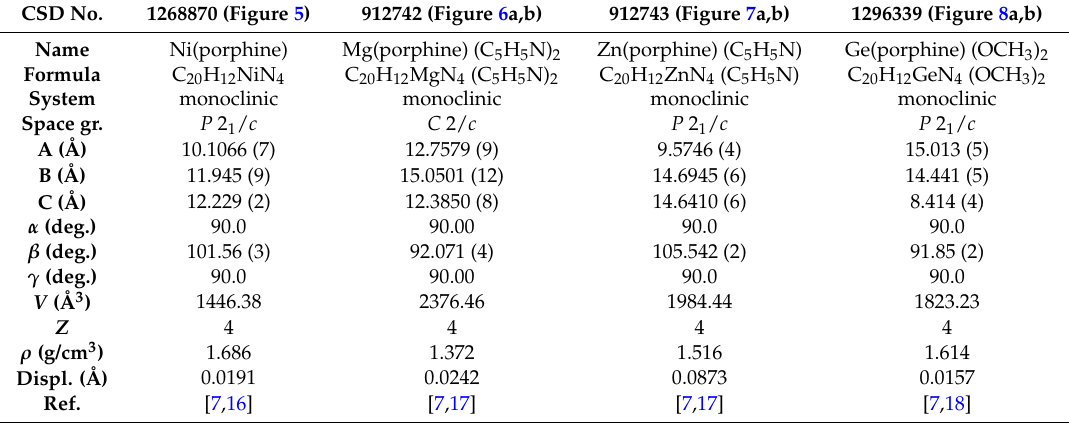
Table 3. Crystallographic Properties of Selected Metalated Porphines (no substituents). CSD